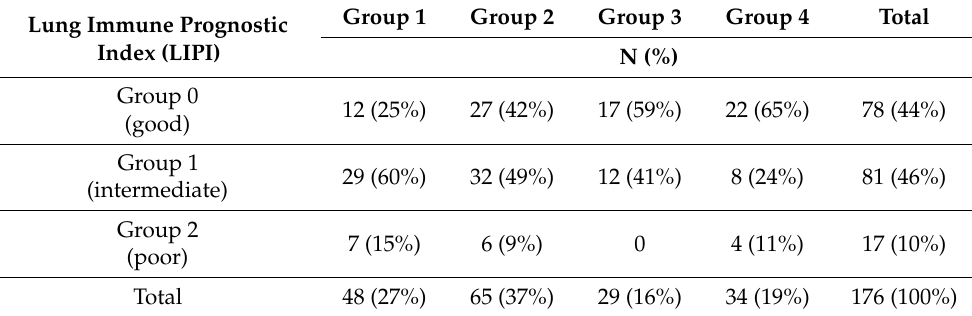
Table 6. Calculated LIPI values in analyzed groups of patients .